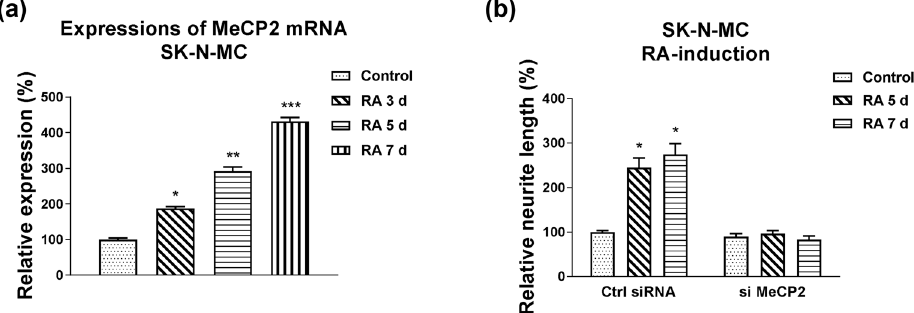
Figure S4: Silencing MeCP2 suppresses RA - induced neuron di ff erentiation. ( a ) SK - N - MC cells under RA treatments for 3, 5 and 7 days, expressions of MeCP2 were determined by qRT - PCR. ( b ) The relative neurite length was calculated in SK - N - MC cells without or with MeCP2 silencing under RA treatments for 5 and 7 days. *, p < 0.05; **, p < 0.01; ***, p <